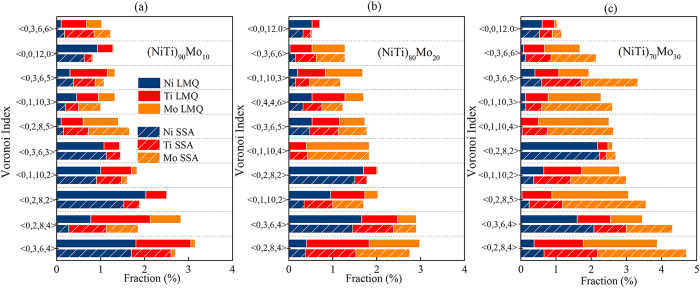
Populations of the dominant coordination clusters of the obtained MGs: (NiTi)90Mo10 (a), (NiTi)80Mo20 (b) and (NiTi)70Mo30 (c).